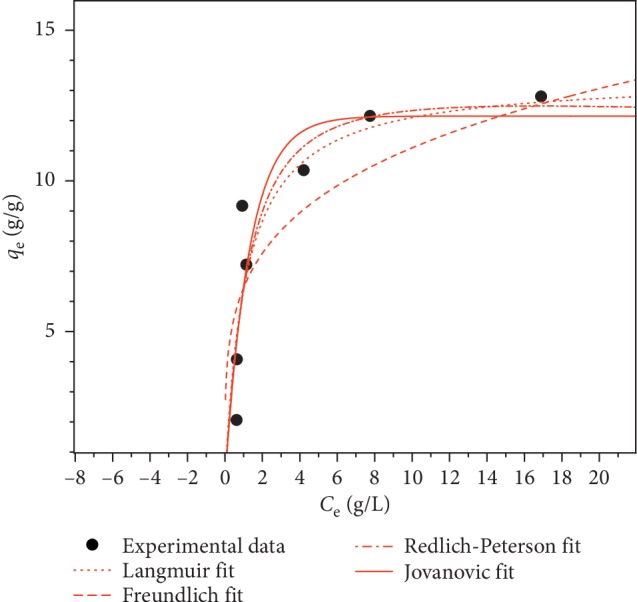
Sorption isotherms of oil onto PO milled fibers and fittings with Langmuir, Freundlich, Redlich-Peterson, and Jovanovic models (biosorbent dose = 0.05 g).